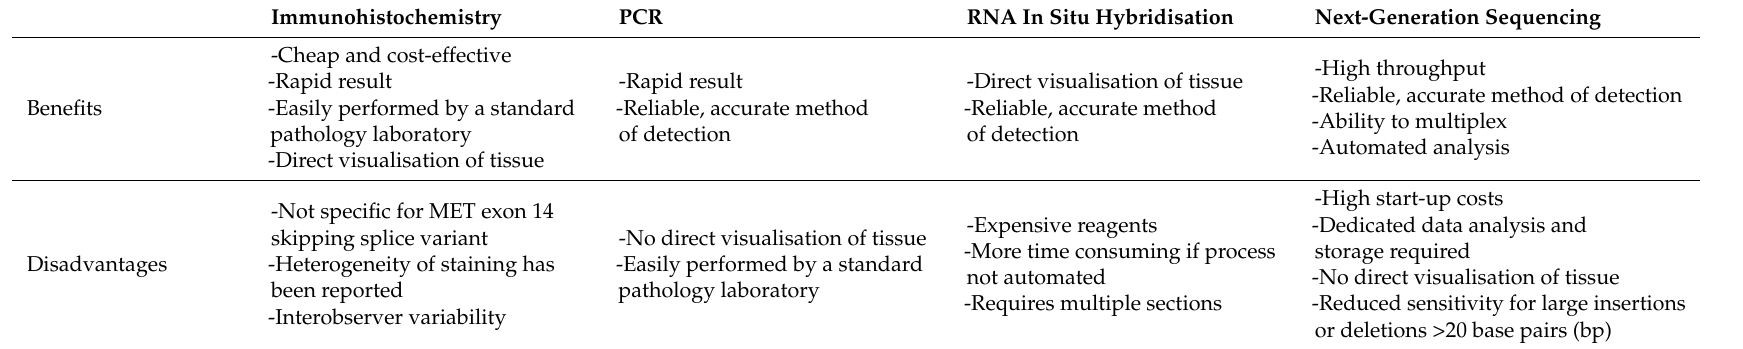
Table 3. Comparison of common modalities used for the detection of METex14